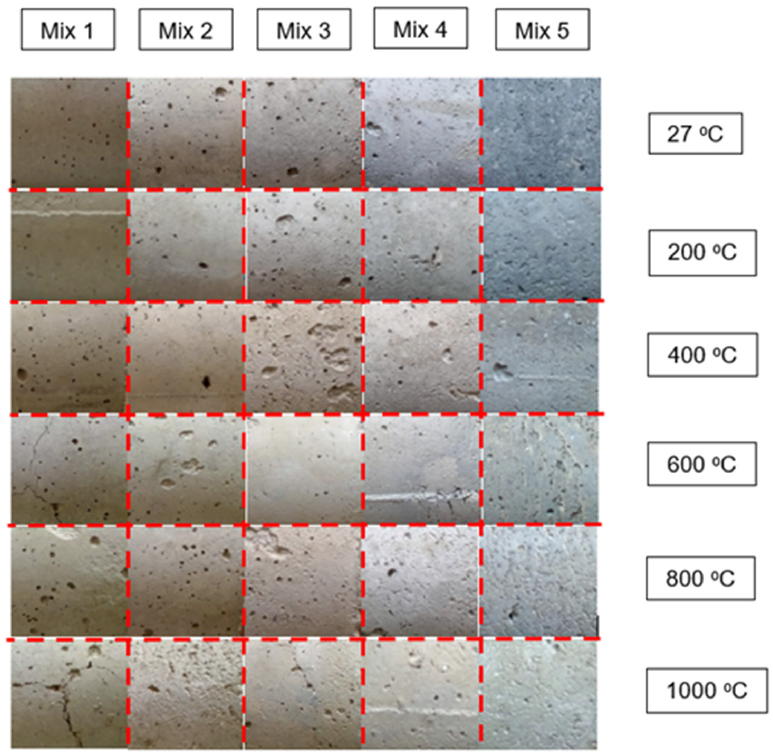
Figure 3. Colour changes of samples at elevated temperatures immediately after removal from the furnace.